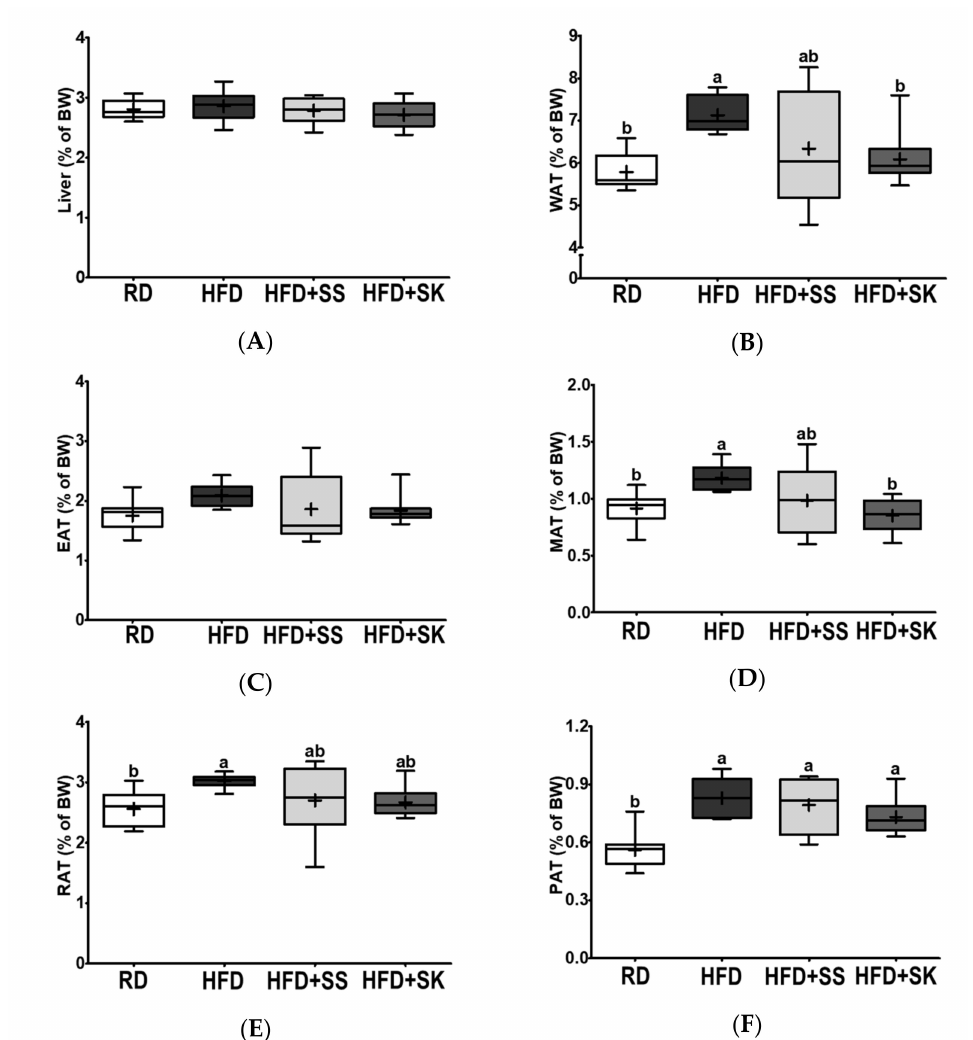
Figure 2. Effects of steamed soybean (SS) and soybean koji (SK) on the relative liver and white adipose tissue weight in HFD-fed Sprague-Dawley rats. Experimental rats were fed a regular diet (RD) or a high-fat diet (HFD) with 3% SS (HFD+SS) or with 3% SK (HFD+SK) for 8 weeks. Relative weights of ( A ) liver, ( B ) white adipose tissue (WAT), ( C ) epididymal adipose tissue (EAT), ( D ) mesenteric adipose tissue (MAT), ( E ) retroperitoneal adipose tissue (RAT), and ( F ) perirenal adipose tissue (PAT). Relative tissue weights (%) were calculated as organ weight (g)/final BW × 100. RD, regular diet; HFD, high-fat diet; HFD+SS, high-fat diet + 3% steamed soybean; HFD+SK, high-fat diet + 3% steamed soybean. Values are displayed as a box-and-whisker plot with means (expressed as ‘+’), n = 8. Data were analyzed using one-way ANOVA followed by Tukey’s post-hoc comparison. a,b Means labeled without a common letter differ significantly, p <